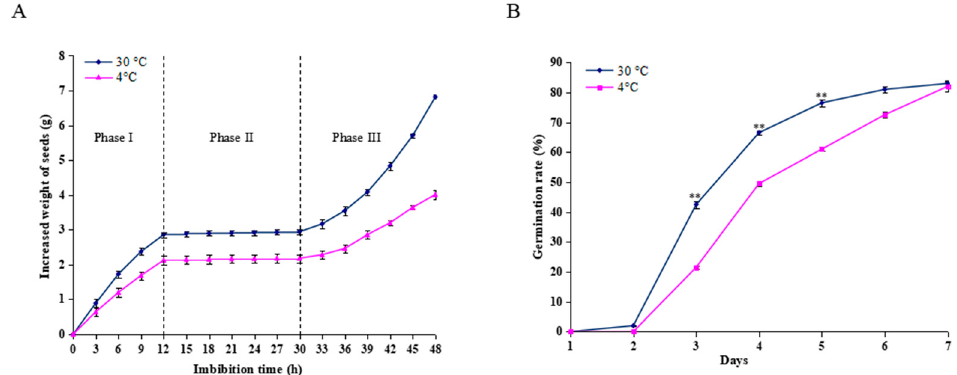
Figure 1. Effect of cold stress on seed imbibition and germination. ( A ) Triphasic pattern of water uptake under the cold stress (4 °C) and control conditions (30 °C). ( B) Seed germination rate was calculated after the seeds imbibed at 4 °C and 30 °C for 12 h. For the cold stress treatment, the seeds were imbibed at 4 °C for 12 h, and then transferred to 30 °C for germination, and for the control, the seeds were allowed to germinate at a constant 30 °C only. Values represent the means ± SD from three fully independent biological replicates. * p < 0.05, ** p < 0.01 by Student’s t ‐ test.